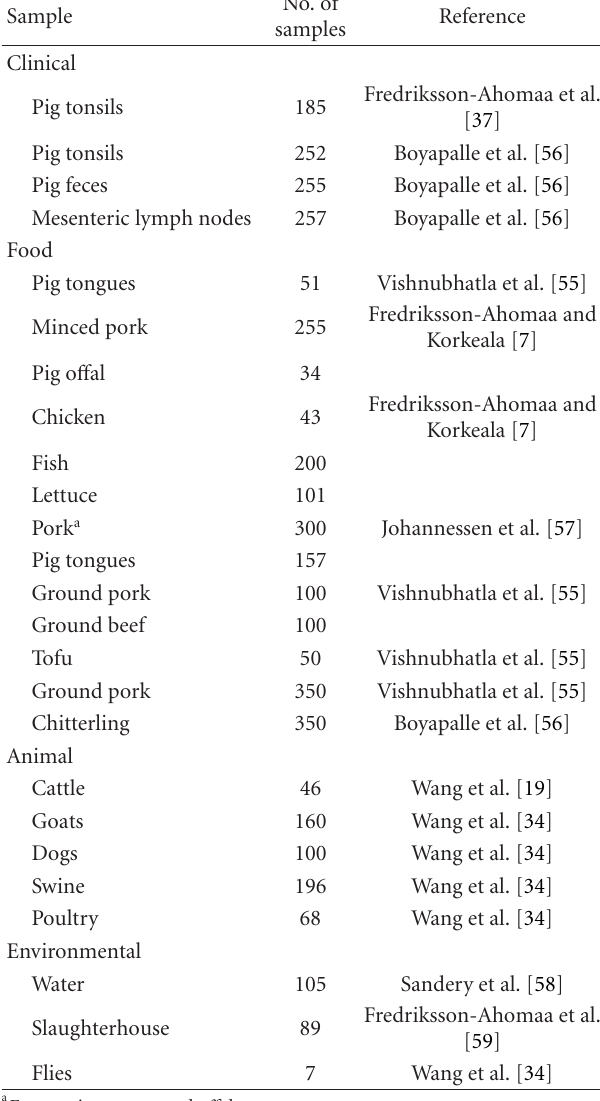
Table 5: Detection of pathogenic Yersinia enterocolitica in natural